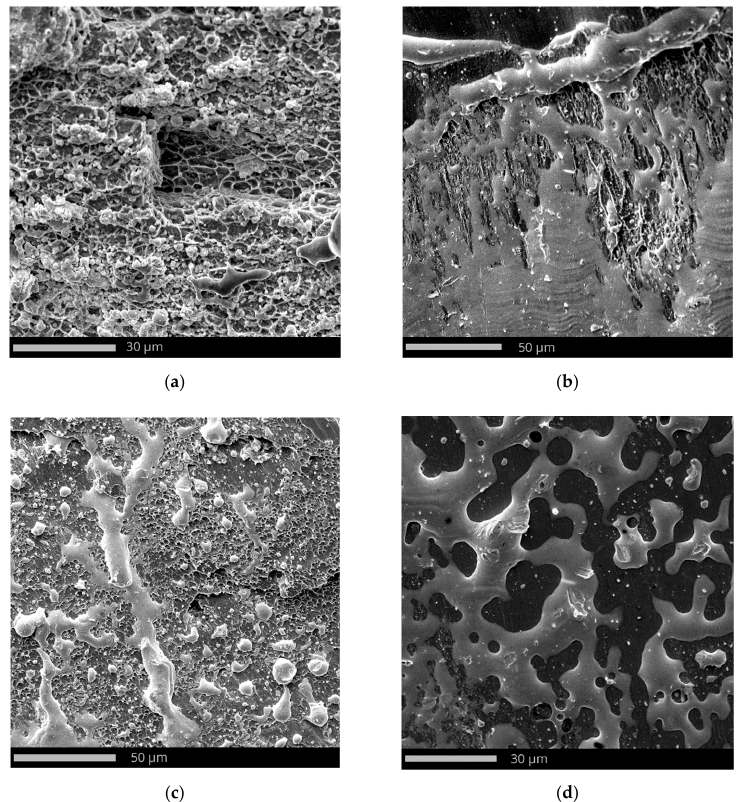
Figure 13. Crack at the edge of the hit.